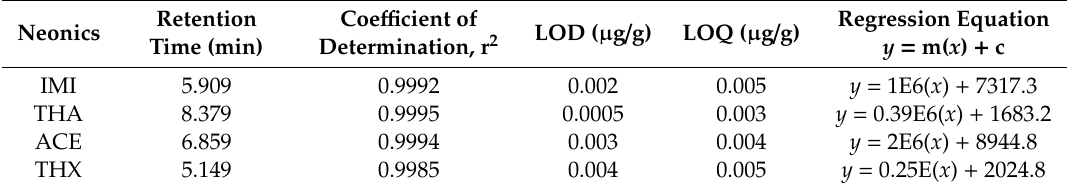
Table 3. Neonics standard solutions linear range, retention time, coe ffi cient of determination, r 2 , limit of detection (LOD), limit of quantification (LOQ) and regression equation. (Neonics